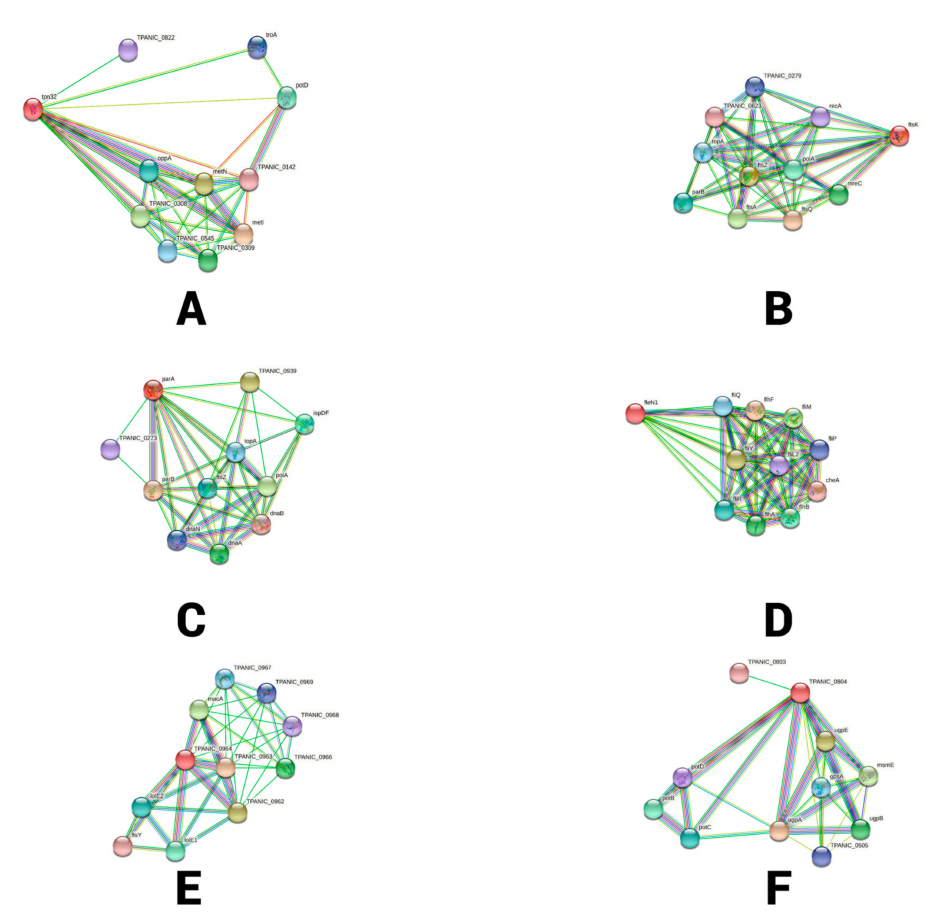
Figure 3. The antigenic proteins and protein interaction (PPI) through the STRING database. ( A ) Pro- tein 1: 007950|TPN32_TREPA Membrane lipoprotein TpN32; ( B ) Protein 2: O83964|FTSK_TREPA DNA translocase FtsK; ( C ); Protein 3: O83296|SOJ_TREPA Protein Soj homolog ( D ); Protein 4: F7IVD2_TREPA site-determining protein; ( E ) Protein 5: O83930_TREPA ABC transporter, ATP- binding protein; ( F ) Protein 6: O83782_TREPA Sugar ABC superfamily ATP-binding cassette trans- porter, ABC